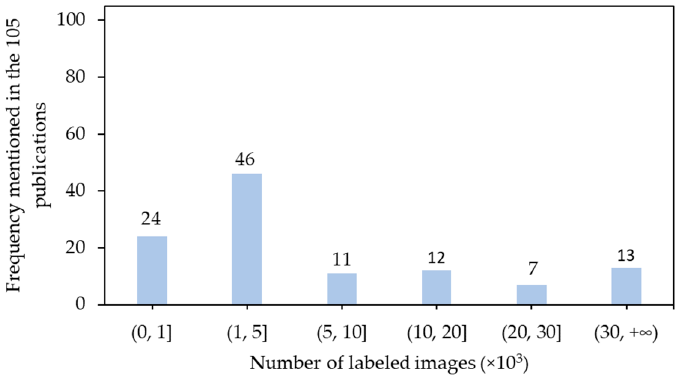
Figure 7. Frequency mentioned in the 105 publications corresponding to number of labeled im-